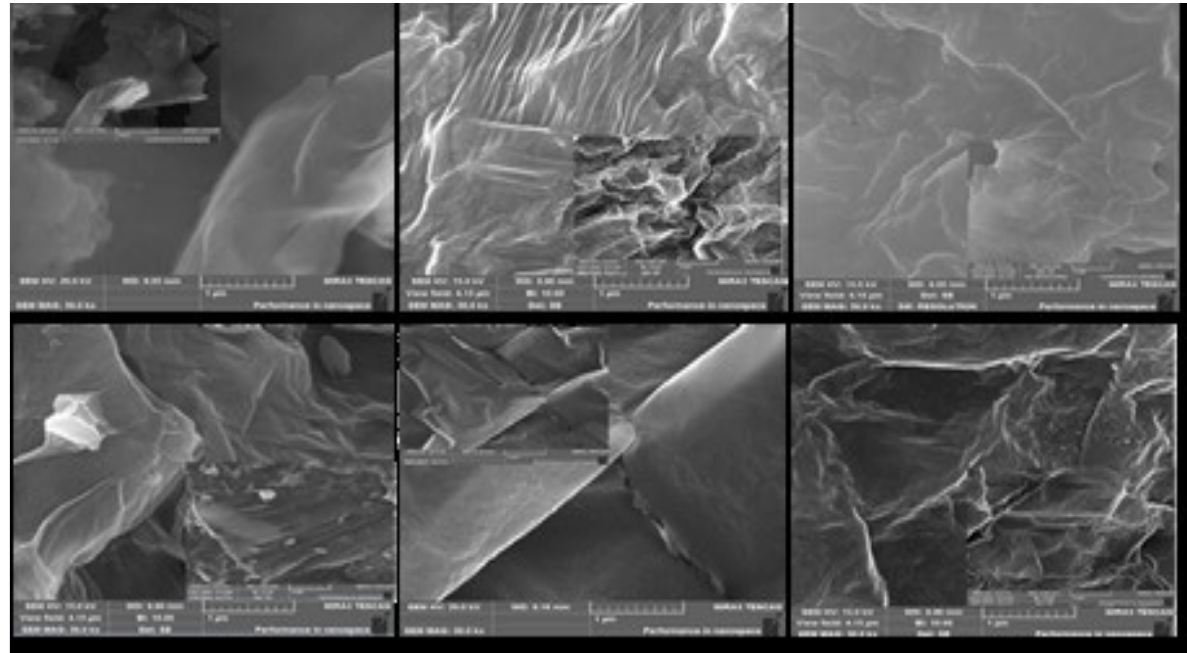
Figure 2: FESEM micrographs of a) 0.05%-1h-50V GO, b) 0.05%-30min-50V GO, c) 0.025%-1h-50V GO, d) 0.025%-1h-25V GO e) 0.025%-1h-